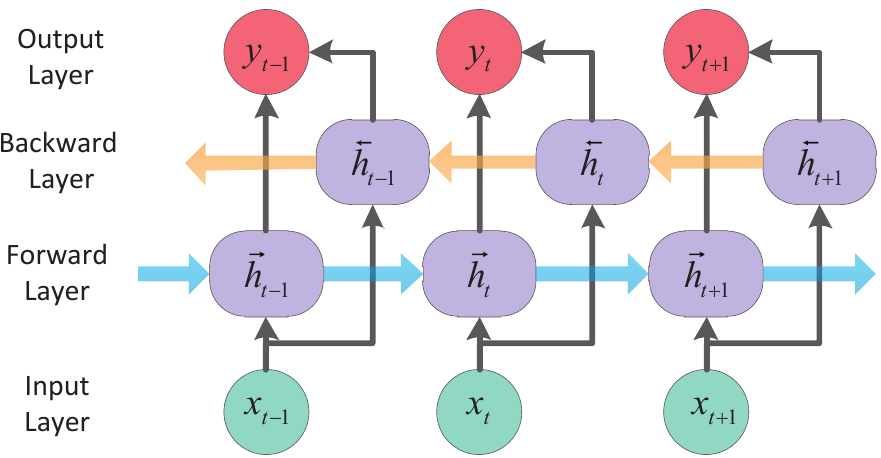
Figure 4. Bi-LSTM neural network